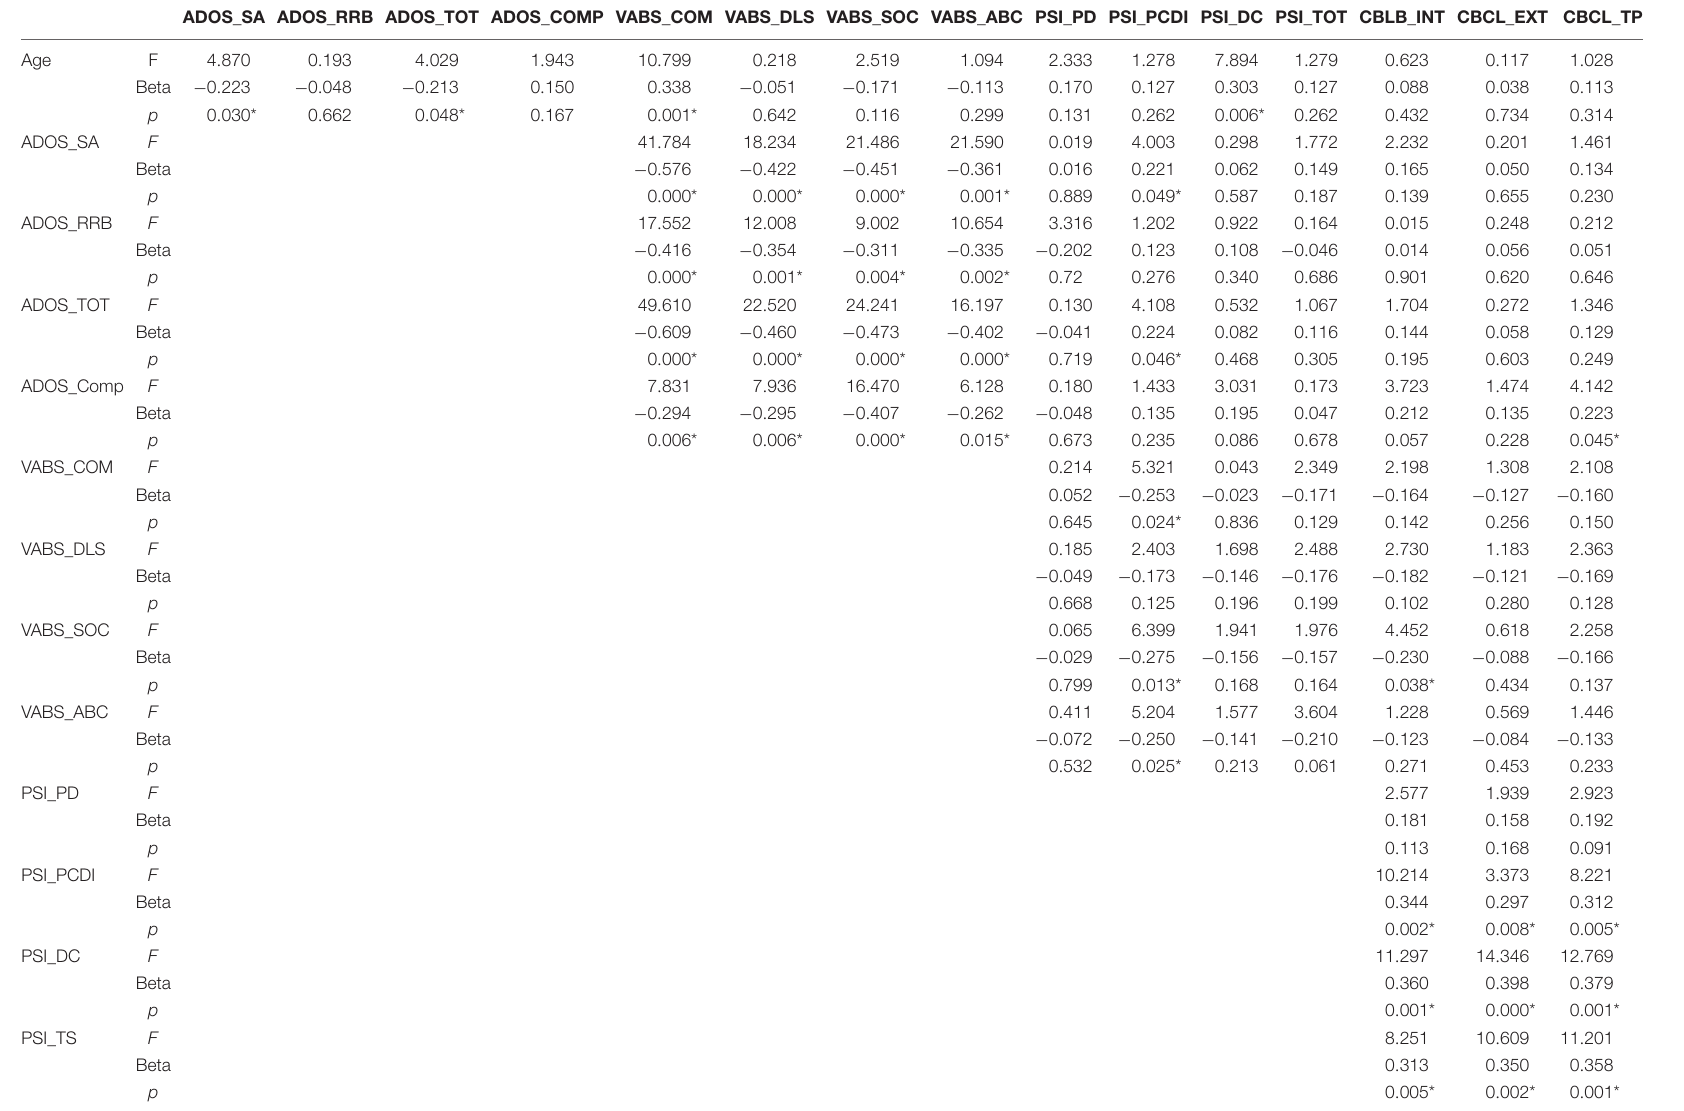
TABLE 5 | Linear regression